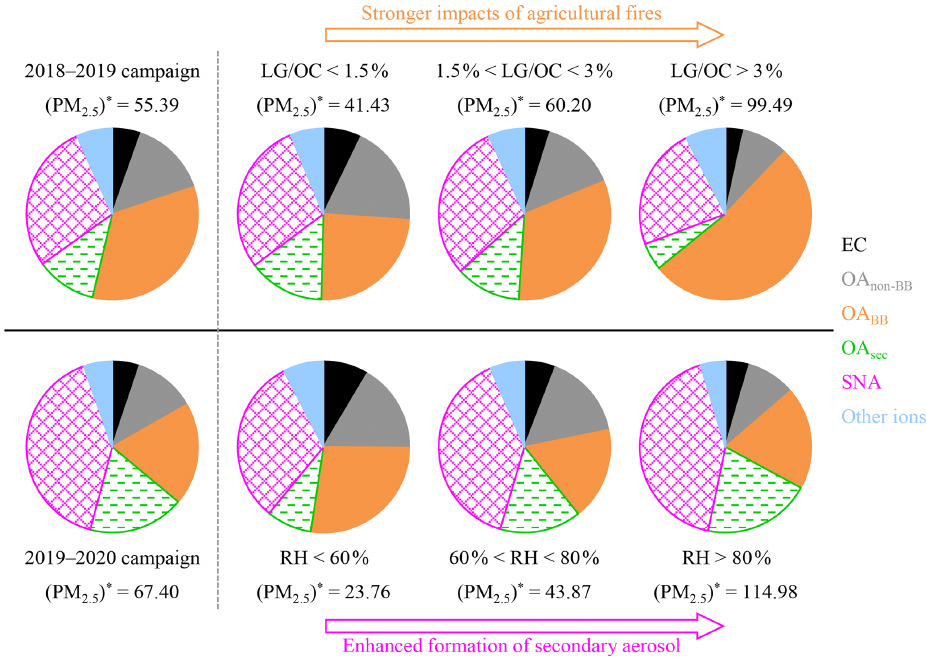
Figure 8. Comparison of aerosol compositions measured for the 2018–2019 and 2019–2020 campaigns. The 2018–2019 measurement period experienced relatively dry meteorological conditions (with RH levels rarely exceeding 80%) and was characterized by a wide window of ∼ 3 months for legitimate burning. Correspondingly, variations of (PM 2 . 5 ) ∗ concentration (in µg/m 3 ) and aerosol composition observed during 2018–2019 were mainly driven by agricultural fires. However, the legitimate burning policy was terminated in 2019, and the 2019–2020 campaign did not show clear evidence for apparent influence of agricultural fires. On the other hand, high-RH conditions occurred much more frequently during the 2019–2020 measurement period compared to 2018–2019. Correspondingly, variations of (PM 2 . 5 ) ∗ concentration and aerosol composition observed during 2019–2020 were mainly driven by RH-dependent increase of secondary aerosols.